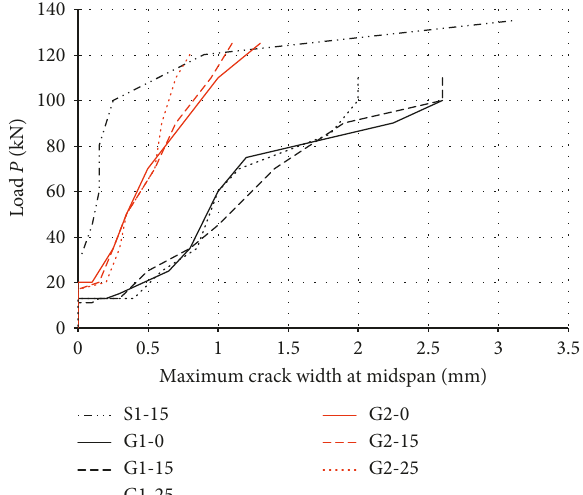
Figure 6: Load-maximum crack width relationship at the midspan for tested beams.